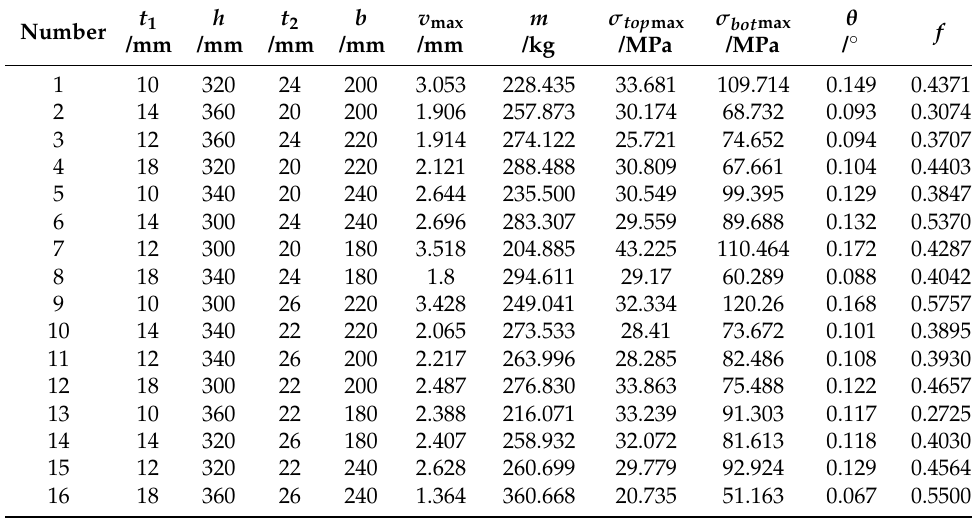
Table 1. Orthogonal design of single beam and